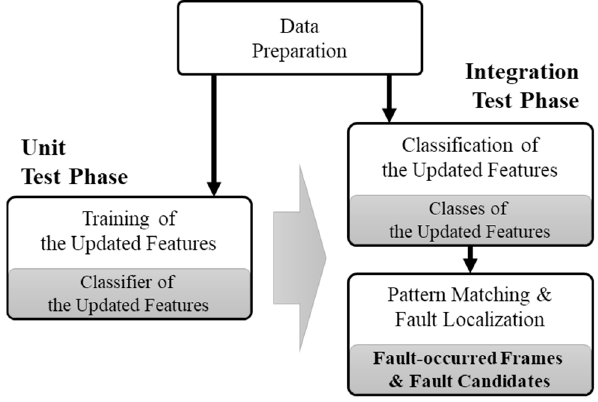
Figure 7. Process of fault localization using memory-updated patterns.